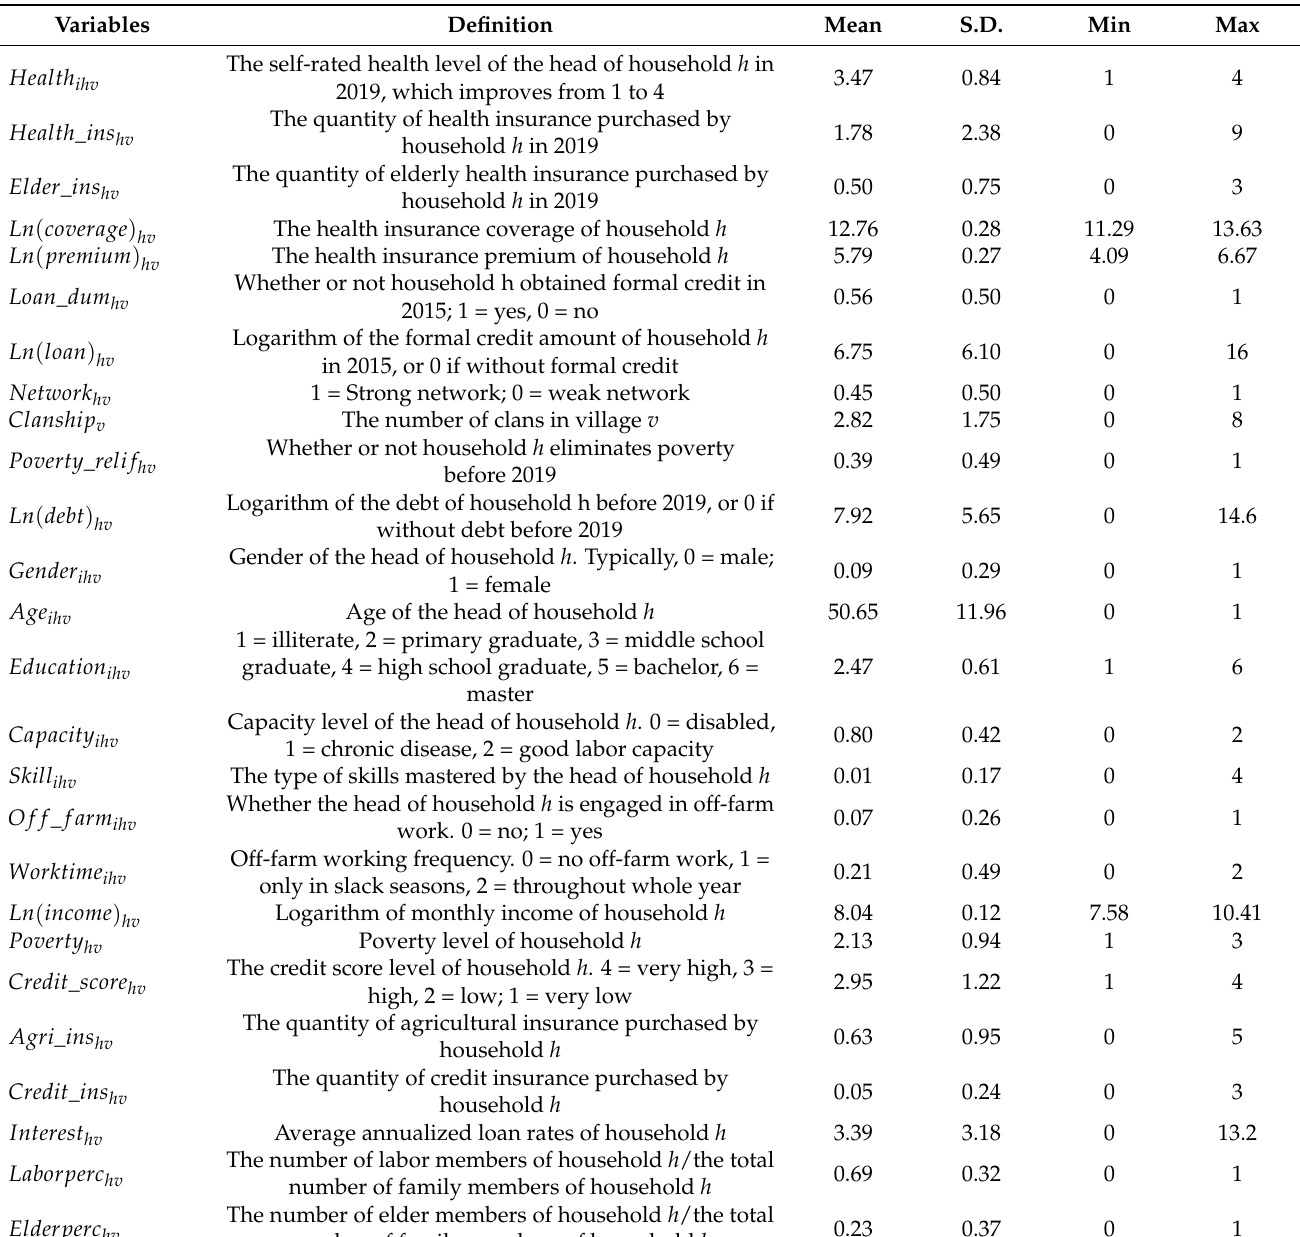
Table 1. Descriptive